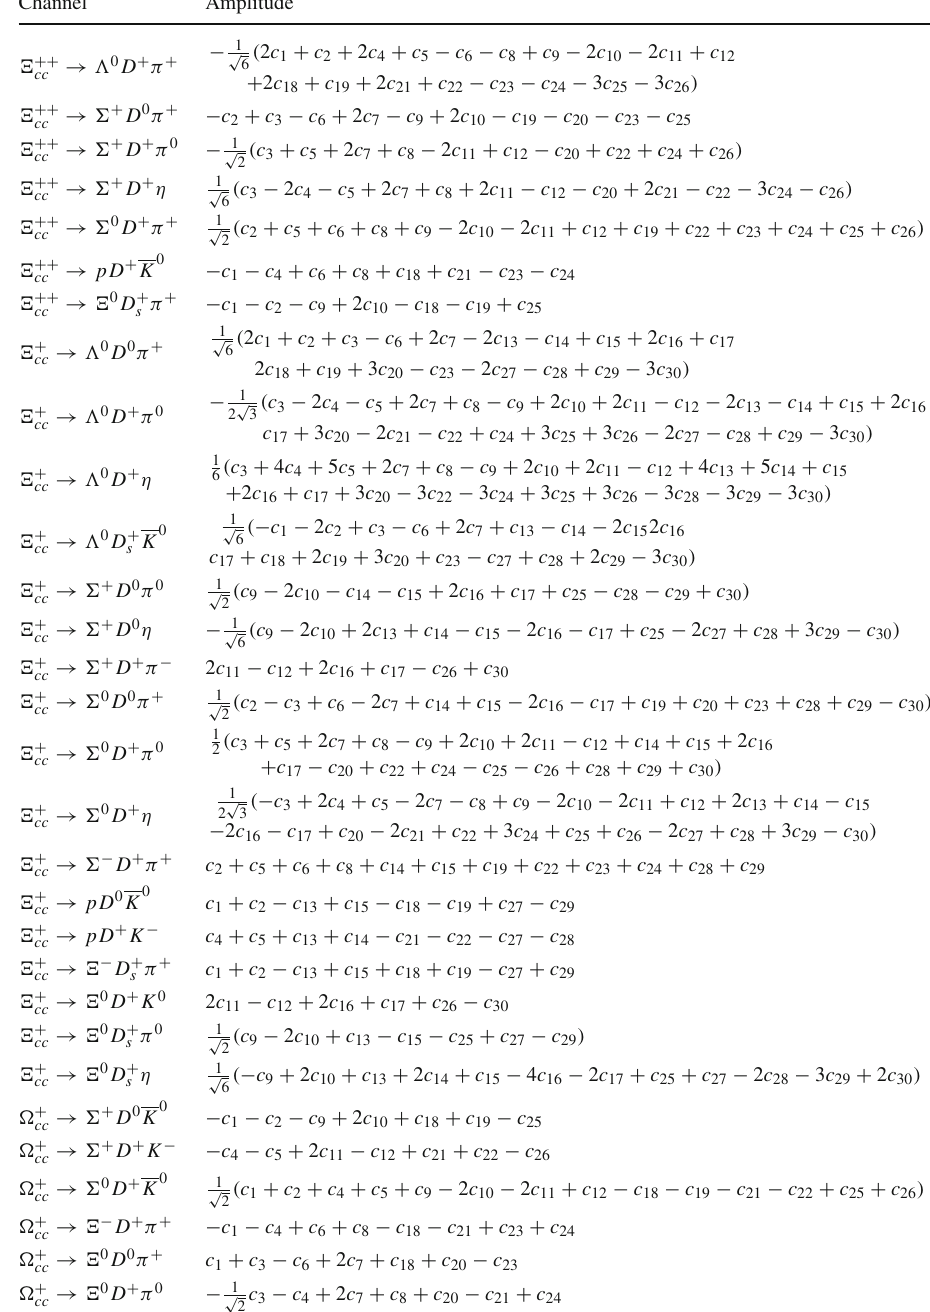
Table 11 Doubly charmed baryon decays into a light baryon in the octet, a charmed meson and a light meson